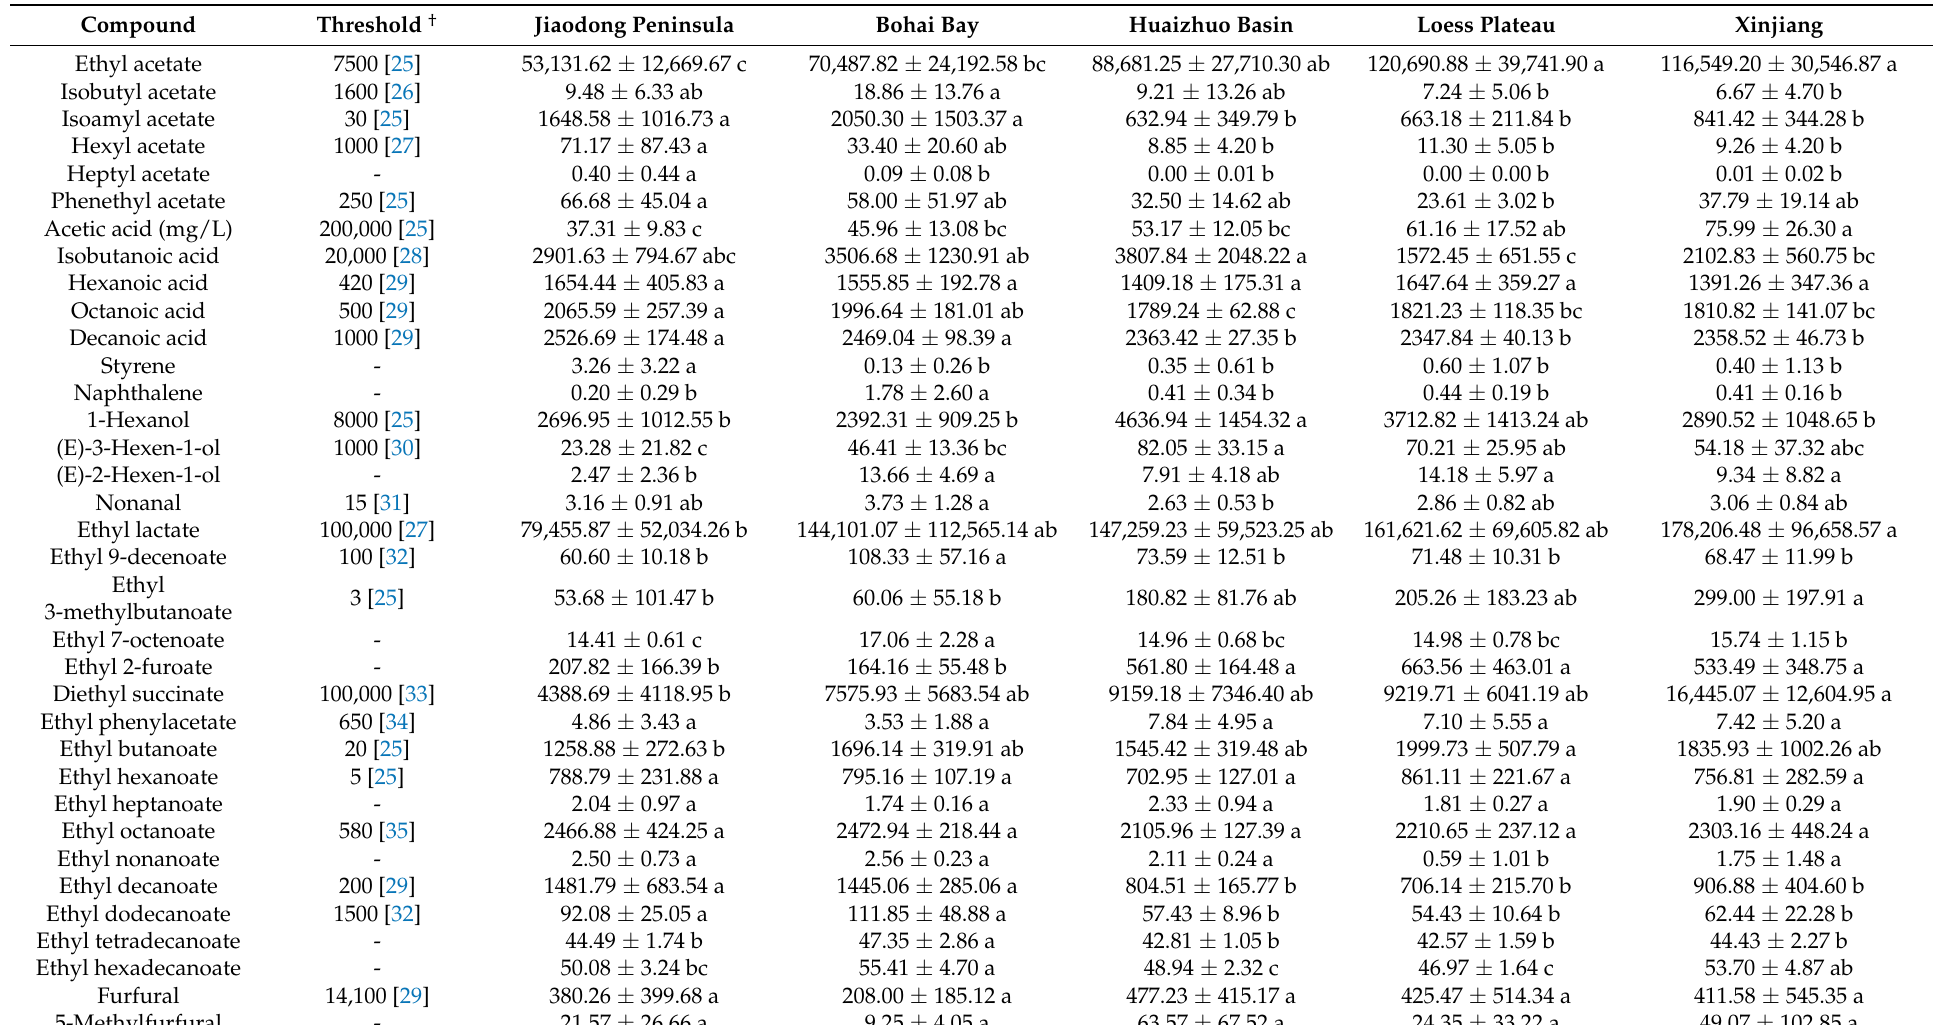
Table 2. Concentrations and thresholds ( µ g/L) of the volatile compounds of Marselan wines from different regions of China